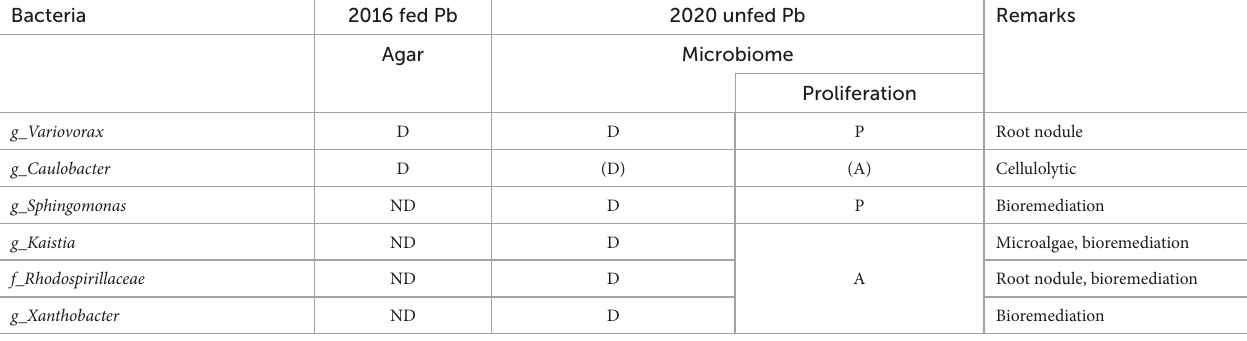
TABLE 2 Comparison of bacterial taxa detected in fed (2016) and unfed P. bursaria (2020)